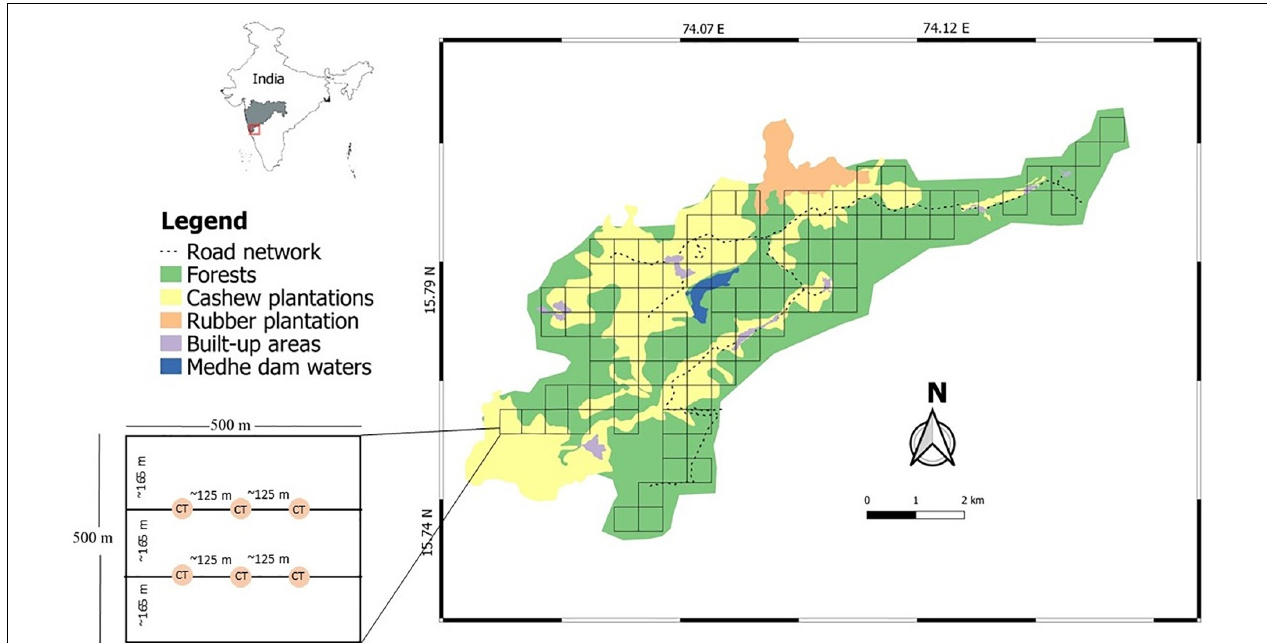
FIGURE 1 | The study area within the Tillari region of India showing major land use types and the gridded sampling design. Major land use types include forests (green), cashew plantations (yellow), rubber plantations (light orange), and built-up rural human populated areas (purple). The inset map shows the location of Tillari (box with red outline) within the state of Maharashtra (shaded in gray). The enlarged grid cell diagram on the left-hand side depicts the placement of camera traps in each grid cell.